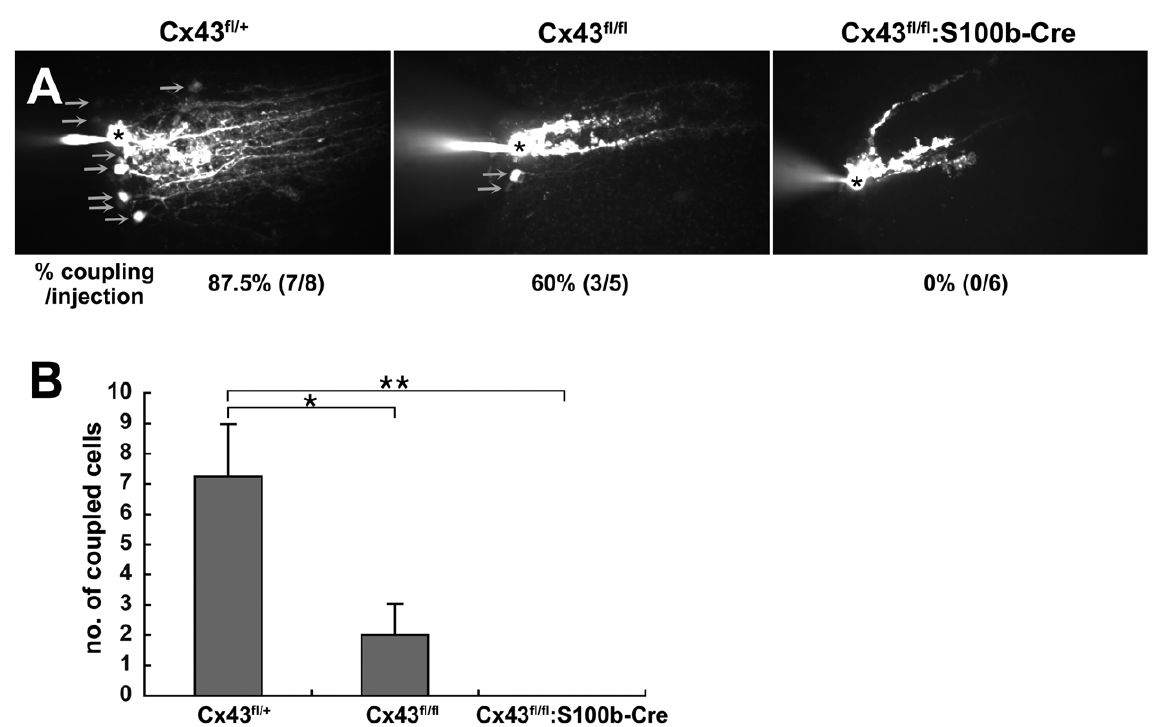
Figure 8. Extent of Lucifer yellow coupling between Bergmann glial cells in Cx43 fl / + , Cx43 fl /fl , and Cx43 fl /fl :S100b-Cre mice. (A) Intercellular Lucifer yellow transfer in Bergmann glial cells in parasagittal cerebellar slices from Cx43 fl / + , Cx43 fl /fl , and Cx43 fl /fl :S100b-Cre mice (3.5 month old) after Lucifer yellow injection into Bergmann glial cell somas. The asterisk indicates a dye-injected Bergmann glial cell body. Arrows indicate representative dye-coupled Bergmann glial cell bodies. (B) Dye-stained neighboring cells were counted when processes of injected cells were stained as shown in (A) ( n = 8 for Cx43 fl / + , n = 5 for Cx43 fl /fl , and n = 6 for Cx43 fl /fl :S100b-Cre. Data are represented as the mean + SEM. * , p < 0.05; ** , p < 0.01 in